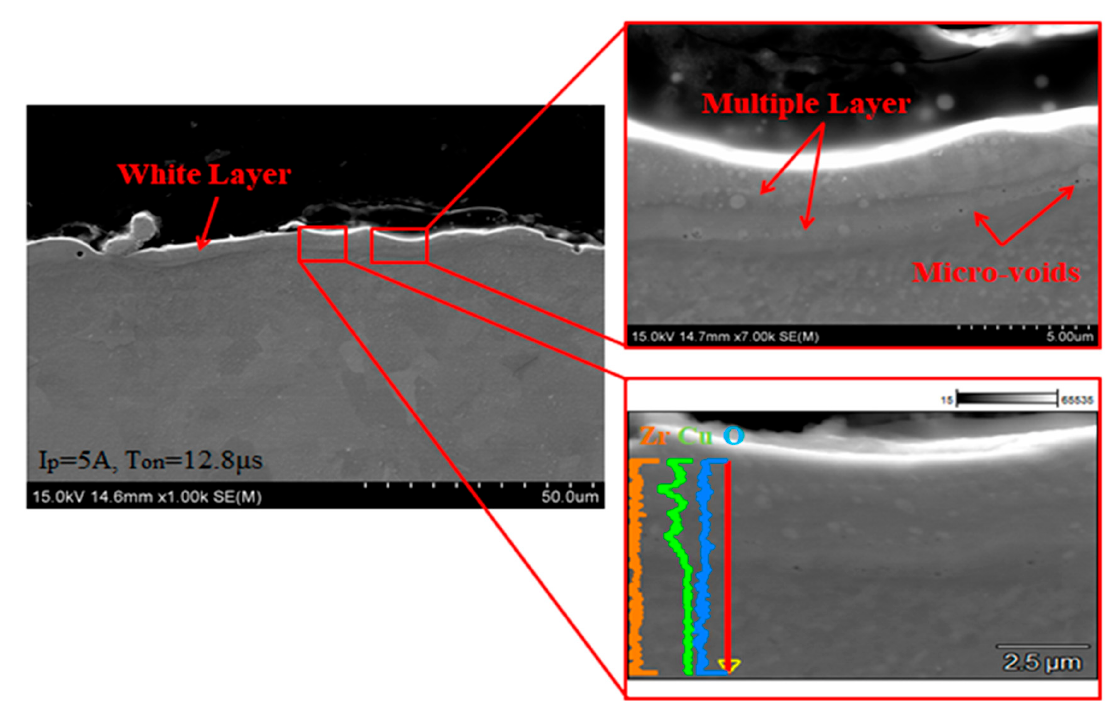
Figure 8. SEM micrographs of the cross section of the machined surface for Ip = 5 A and Ton = 12.8 μ s.